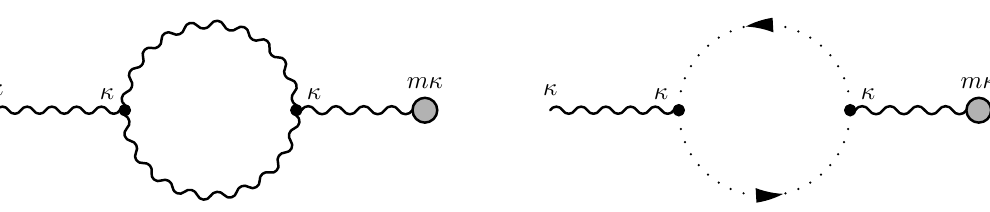
Figure 1. The graviton and ghost loop contributions to hH µν ( x ) i , where wiggly lines denote graviton propagators, dotted lines denote diffeomorphism ghost propagators, the point particle’s stress tensor is shown with a grey circle, and the observation point x is at the left of each diagram. With the proper factors of κ shown in the diagrams, both give quantum corrections proportional to m to the gravitational mκ 4 ∝ G 2 N